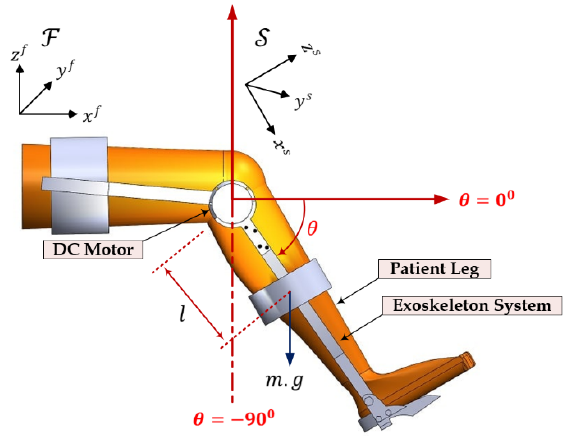
Figure 1. The geometric representation of knee-exoskeleton system dynamic.